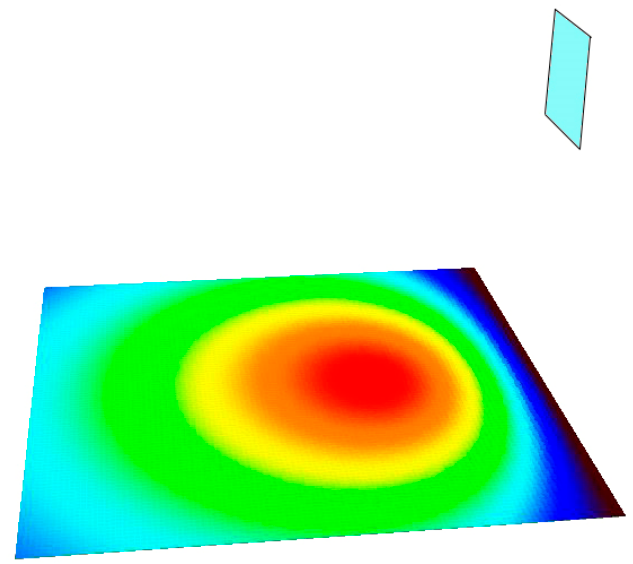
Figure 14. The color map of the configuration factor obtained by discretization for each 10 cm (10201 values) over an area of 10 × 10 m 2 radiated by a ‘rectangle’ of 2 × 2 m 2 , 5 m over the horizontal surface at its middle axis.